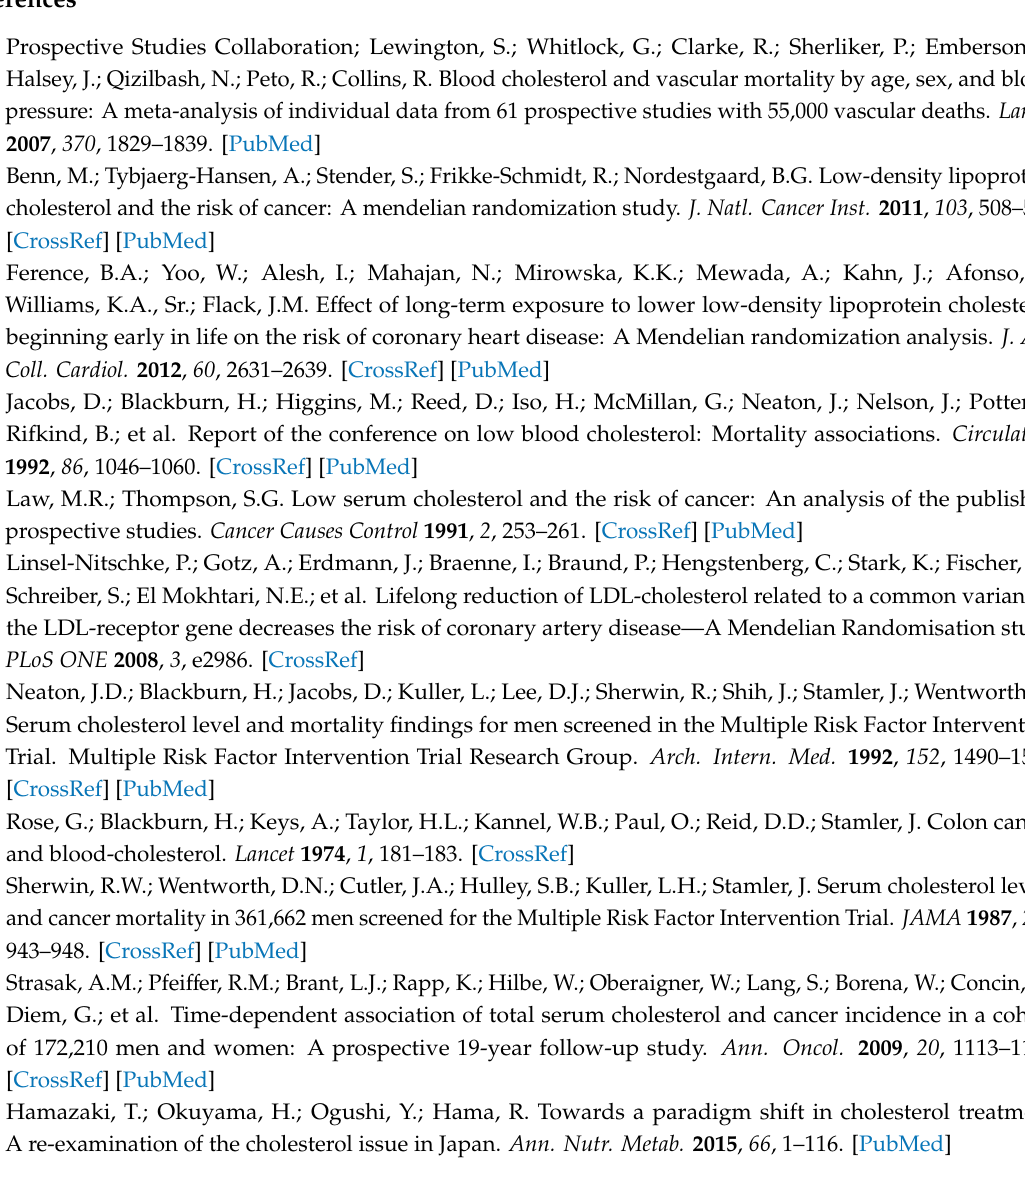
Table S1: Risk of death from all causes according to baseline LDL excluding subjects who died within 3 years of follow up and excluding subjects with existing diabetes or cardiovascular disease at baseline, Table S2: Risk of death from cardiovascular disease according to baseline LDL excluding subjects who died within 3 years of follow up and excluding subjects with existing diabetes or cardiovascular disease at baseline, Table S3: Risk of death from cancer according to baseline LDL excluding subjects who died within 3 years of follow up and excluding subjects with existing diabetes or cardiovascular disease at baseline; Table S4. Baseline characteristics of men according to LDL-C concentrations in KSHS (Men), Table S5. Baseline characteristics of men according to LDL-C concentrations in KSHS (Women), Table S6. Baseline characteristics of participants according to LDL-C concentrations in